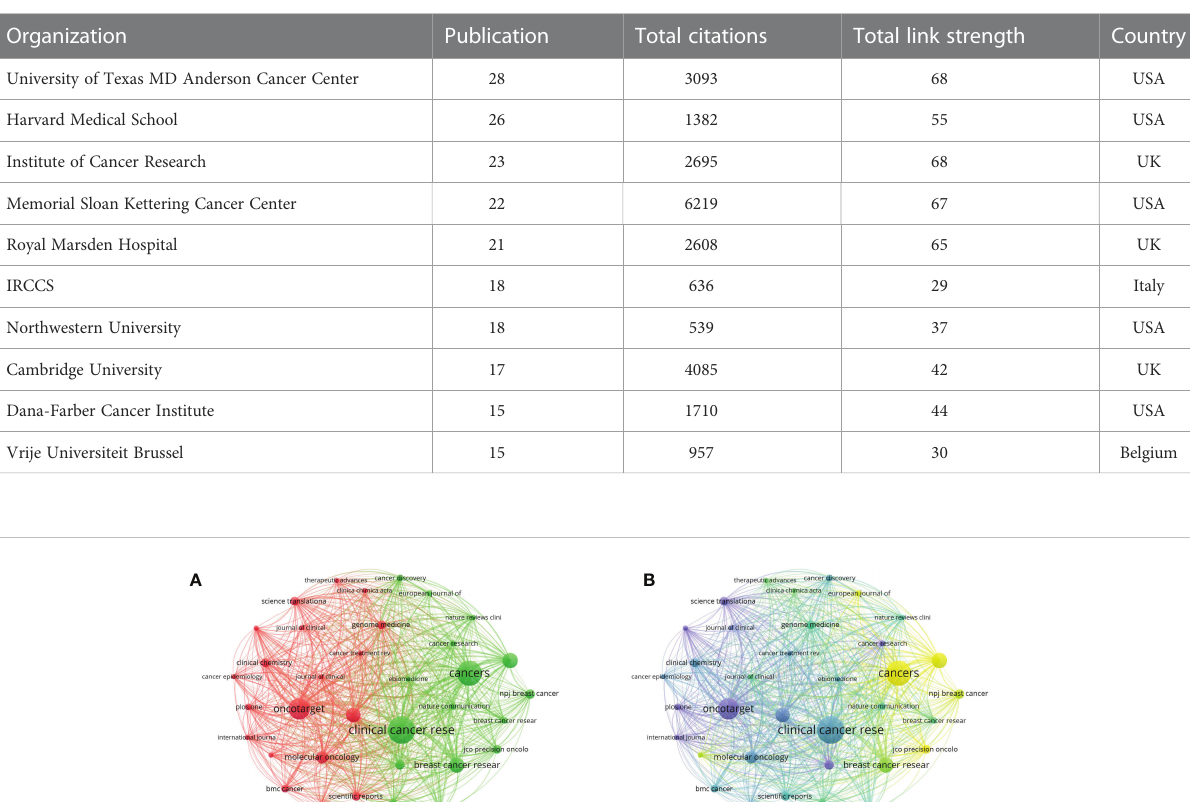
TABLE 2 Top 10 organizations based on